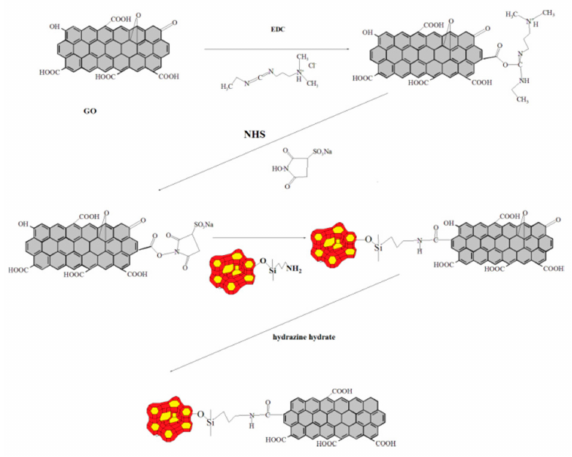
Figure 1. Reaction process of